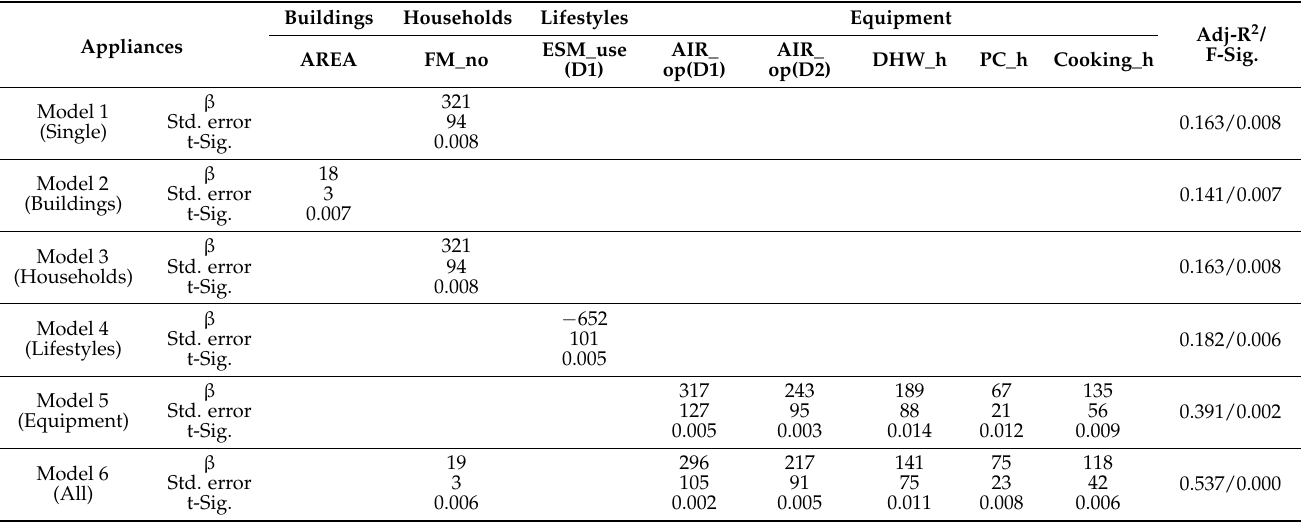
Table 9. Analysis results of valid determinants for domestic